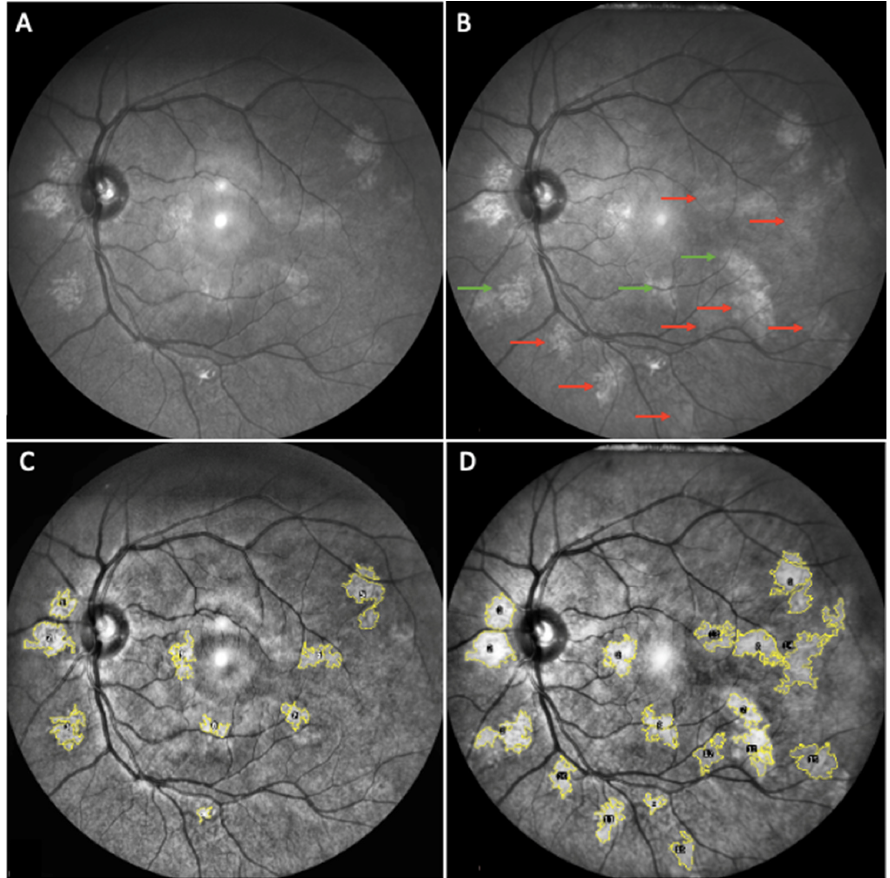
Figure 2. Evidence of the increased number and size of CAs in a NF1 patient. ( A ) (original NIR image) and ( C ) (elaborated image) represent the baseline evaluation; ( B ) (original NIR image) and ( D ) (elaborated image) represent the 3-years follow-up. In ( B ), red arrows indicate new CAs detected; green arrows indicate enlargement of previously observed CAs.